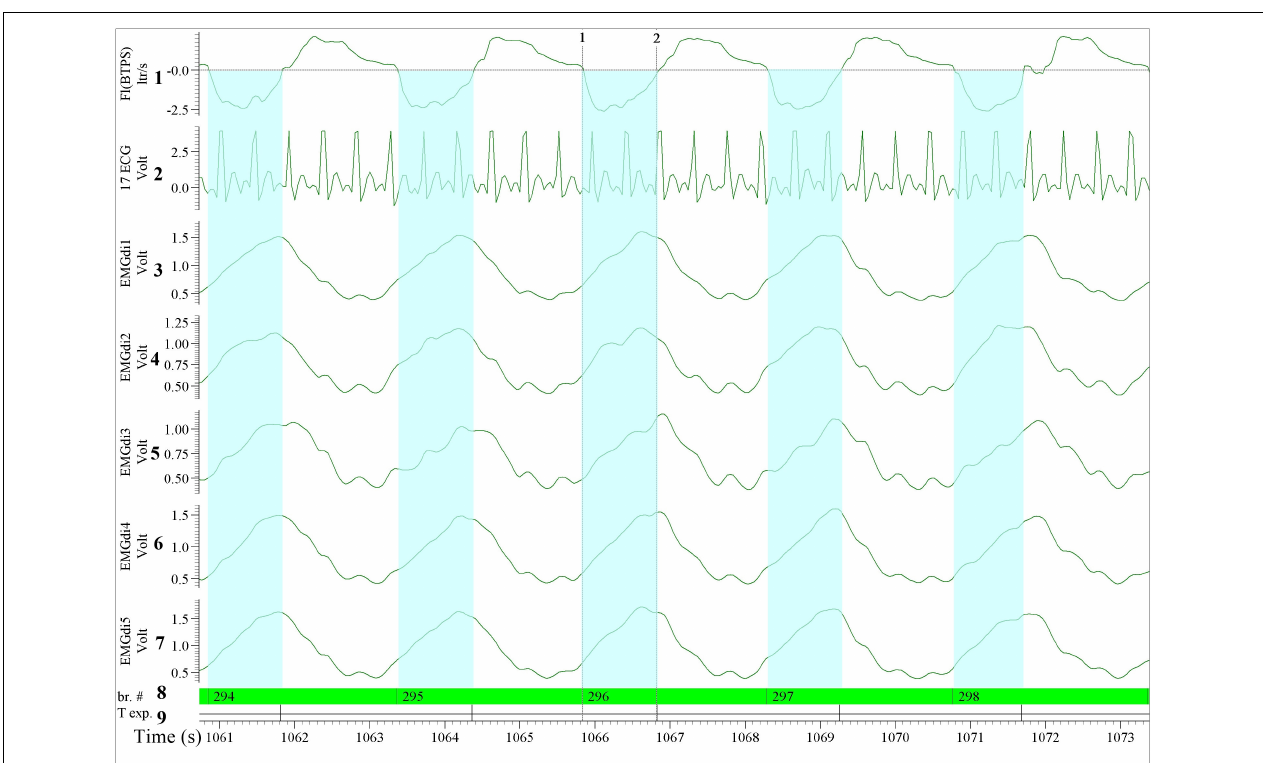
FIGURE 3 | Illustration of the diaphragm EMG (EMGdi) recordings toward the end of the (symptom limited) cycling test (period comparable to Figure 2 ). For the data analysis using the semi-automated method. Channel 1: respiratory flow (l/s; negative flow indicating the inspiratory cycle), Channel 2: ECG recording (volt); The absolute ECG values (volt) from this re-imported data after having been processed in LABVIEW using the semi-automatic algorithm were transformed into an abstract unit. Therefore, the signal appeared to be distorted and cannot be compared directly to the pre-processed ECG signal, Channels 3–7: the processed EMGdi data from our customized algorithm without ECG contamination in the diaphragmatic EMG signal (EMGdi). Channel 8: br.#, beginning of the inspiratory cycle and Channel 9: T exp., beginning of the expiratory cycle indicates the inspiratory and expiratory cycle of each breath which was marked automatically by the program. The EMGdi during a full inspiratory cycle can be selected (highlighted in light blue). The average of the mean EMGdi from every inspiratory cycle in each minute was analyzed. Vertical cursors 1 and 2 indicate a longer period that the value of EMGdi could be retrieved compare to the same breath in Figure 2 that only shorter periods were